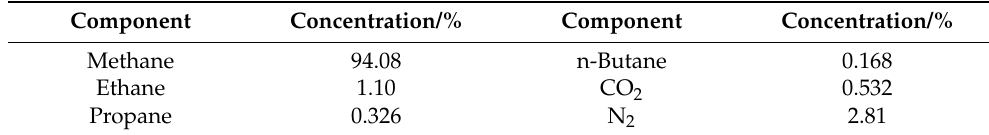
Table 1. Main components of natural gas.